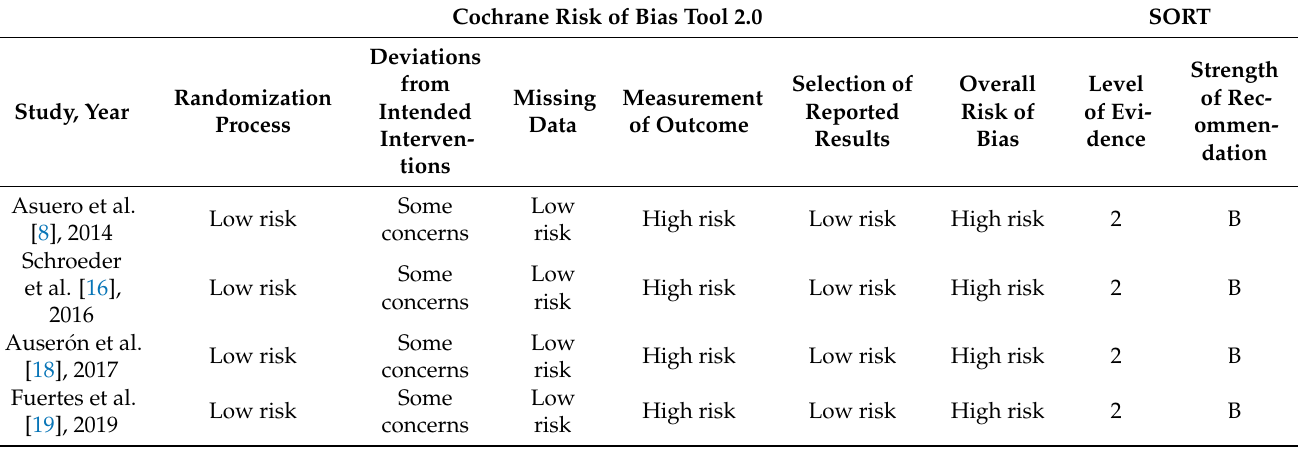
Table 2. Risk of bias, level of evidence, and strength of recommendation for randomized controlled trials. Cochrane Risk of Bias Tool 2.0